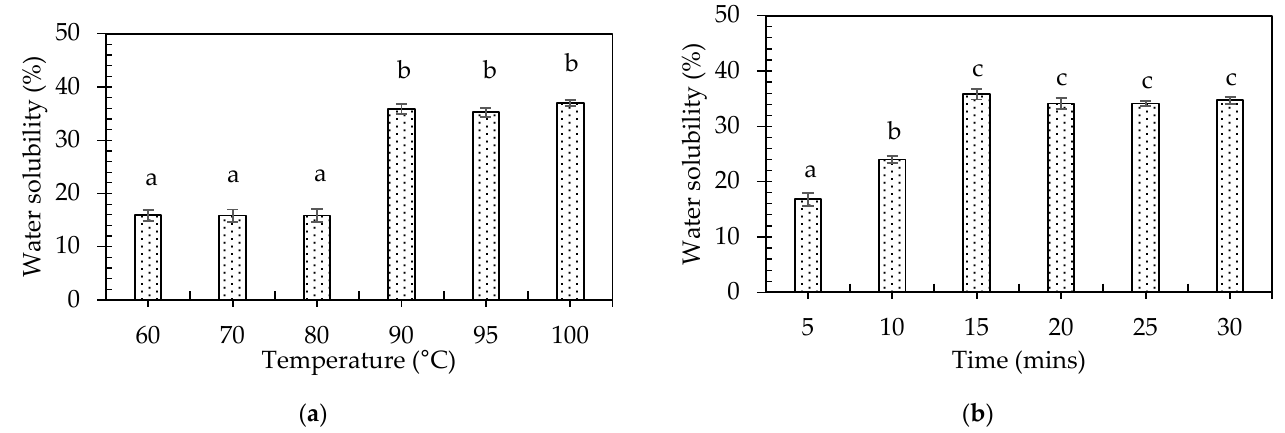
Figure 2. Water solubility of pineapple plants stems under different conditions: ( a ) effect of temperature; ( b ) effect of time. Error bars indicate the mean value ± standard deviation of triplicate of the sample. Values with different letters are statistically different at p ≤ 0.05.